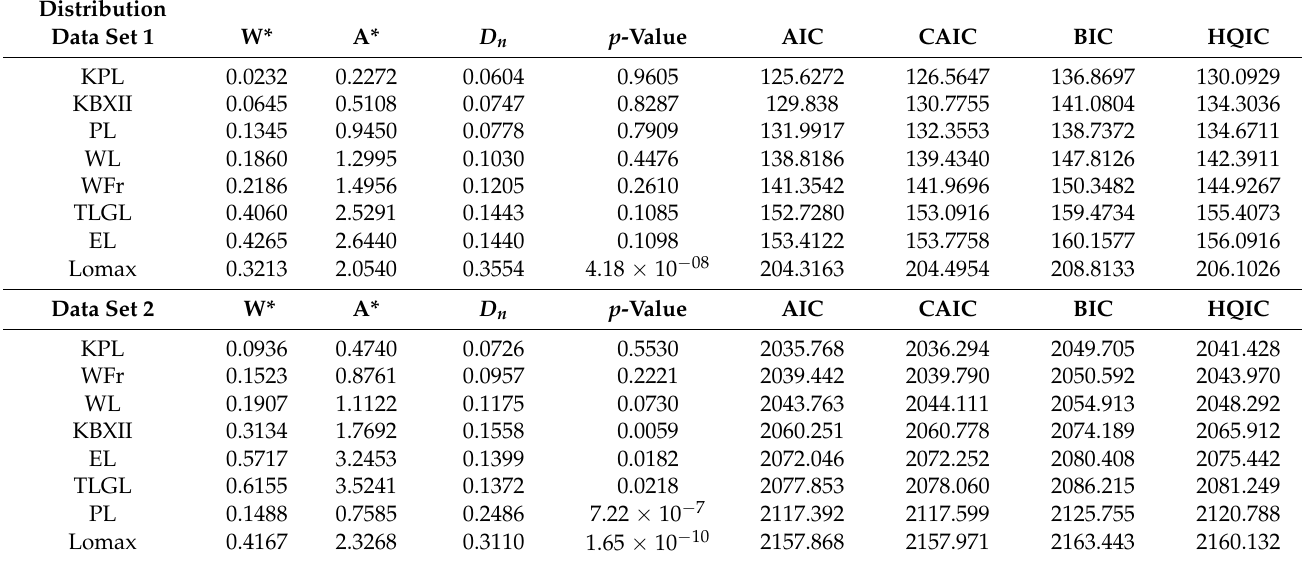
Table 4. The goodness of fit tests and adequacy values for the data